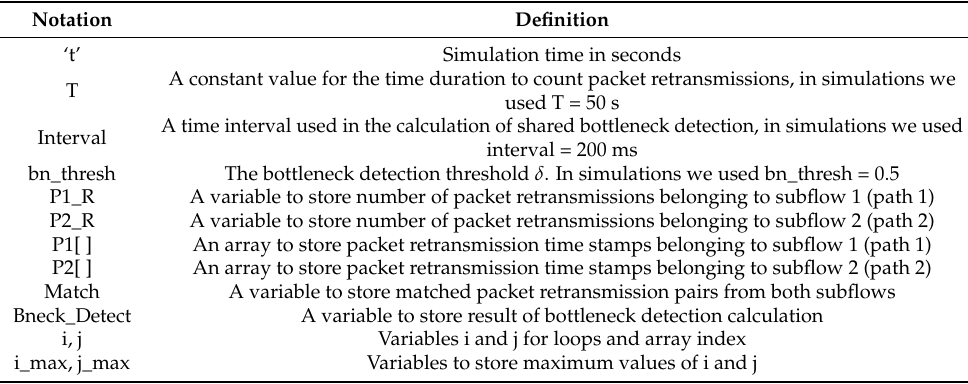
Table 3. Notations used in the proposed